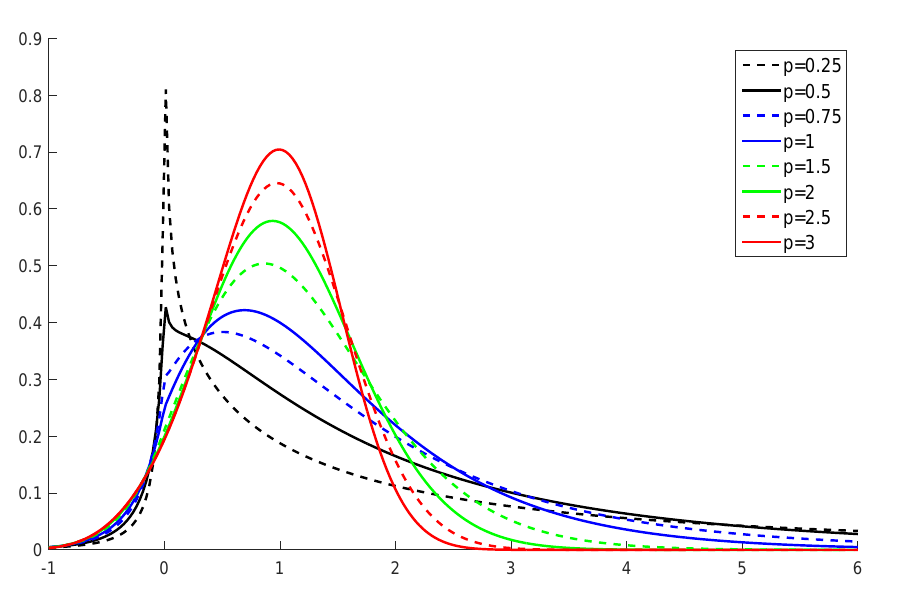
(cid:110) (cid:111) . 1 , 1 , 3 , 1, 3 , 2, 5 , 3 4 2 4 2 2